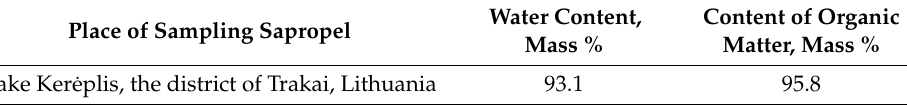
Water Content, Content of Organic Mass % Matter, Mass %